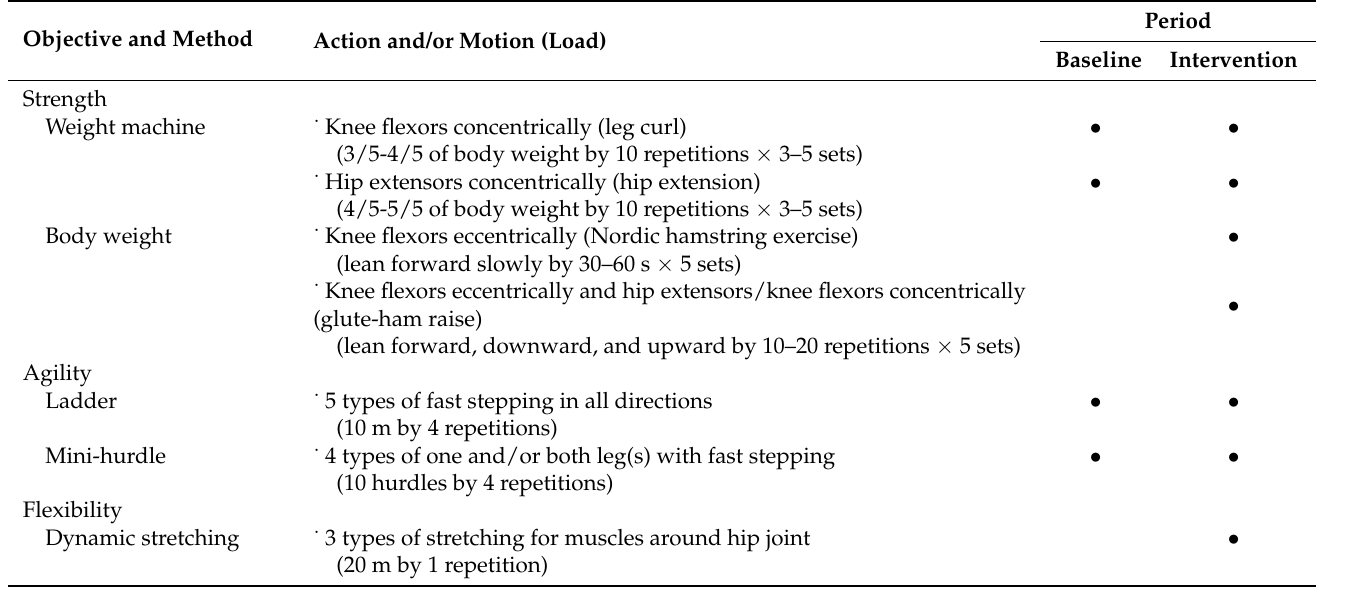
Table 1. Description of the standard preventive program for hamstring